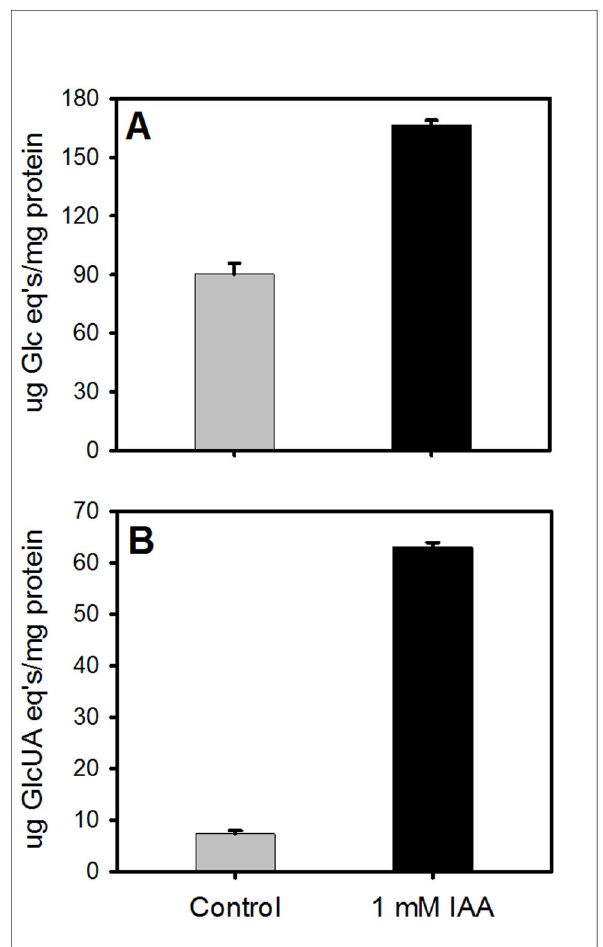
Figure 5. Quantification of the total EPS (A) and acidic carbohydrate content (B). EPSs were isolated from the supernatant of B. japonicum cultures treated with 1 mM IAA (black bars) or control (grey bars). The differences between the two are statistically significant ( P < 0.05). Values are means ± standard errors of the means for three independent experiments with three replications each.